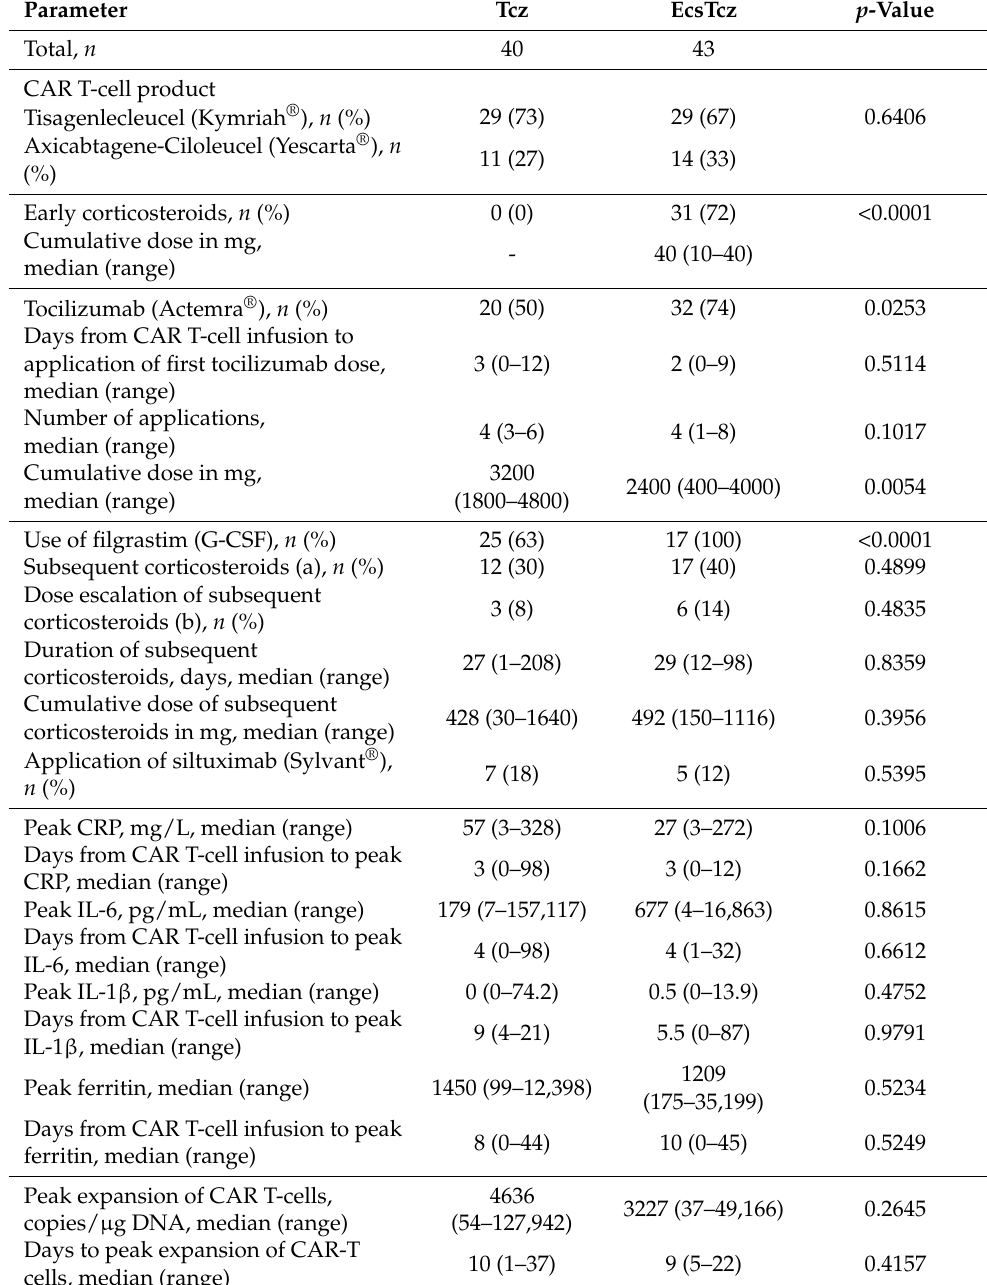
Table 2. Comparison of therapy details and laboratory values during hospitalization period for CAR T-cell therapy in cohorts Tcz vs.